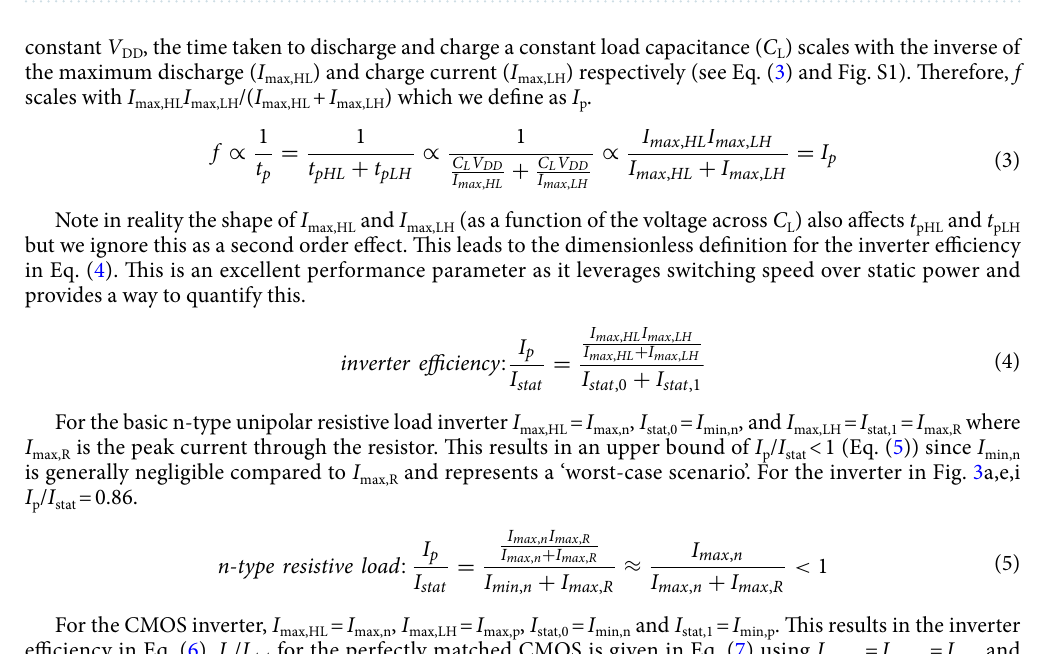
Figure 3. Output characteristics of ISO TFT (W/L) n = 20 (blue) with ( a ) 6MΩ resistor, ( b ) SnO (W/L) p = 100, ( c ) SnO (W/L) p = 20, ( d ) perfectly matched p-type TFT. ( e – h ) Corresponding inverter voltage transfer characteristics, MEC noise margins are represented by the largest square between the transfer curves. ( i – l ) Inverter current transfer